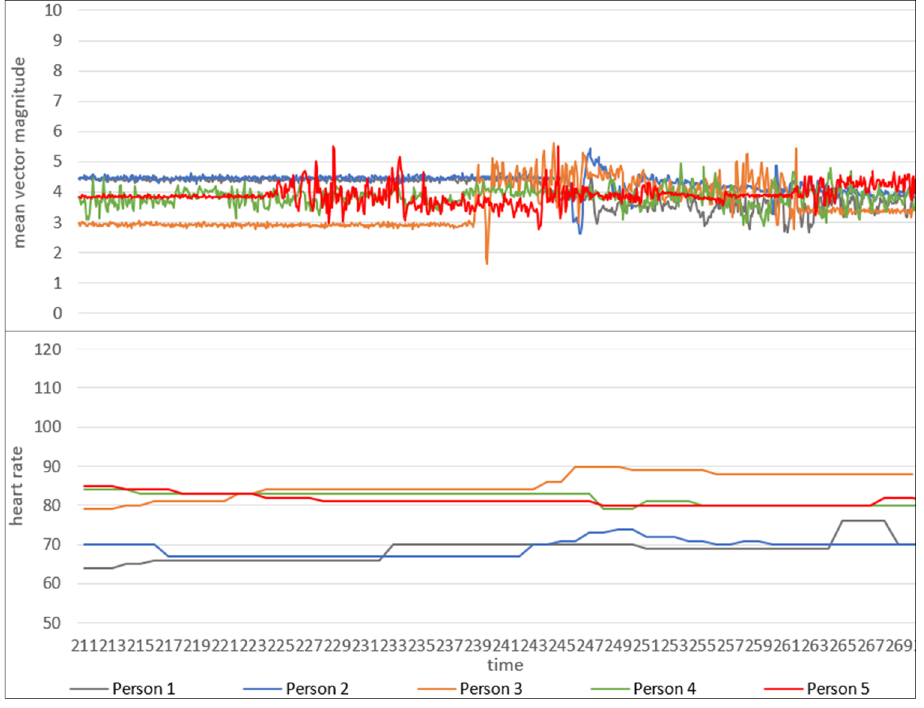
Figure 7. Heart rate and acceleration for the gesture pattern.